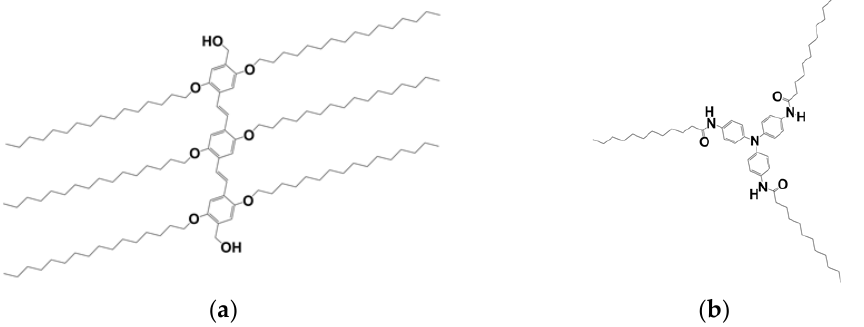
Figure 11. ( a ) OPVOH molecules: the aliphatic arms contain 16 carbon atoms and the terminal groups are OH groups; ( b ) TATA molecules: the aliphatic arms contain 11 carbon atoms.